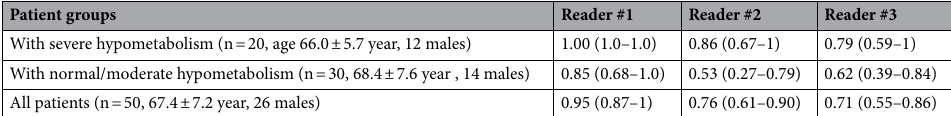
Table 2. Intra-operator concordance between PET STD and PET ULD visual analyses. Cohen’s kappa value and 95% confidence interval characterized by (lower limit-upper limit) are shown. An intra-operator concordance of 1 means that the classification into 7 categories (N, NE, AD, lvPPA, PCA, svPPA, FTD) is the same when the reader visually interprets PET STD and PET ULD. Landis and Koch arbitrary characterized kappa values 0–0.20 as slight agreement, 0.21–0.40 as fair, 0.41–0.60 as moderate, 0.61–0.80 as substantial, and 0.81–1 as almost perfect agreement 6 .